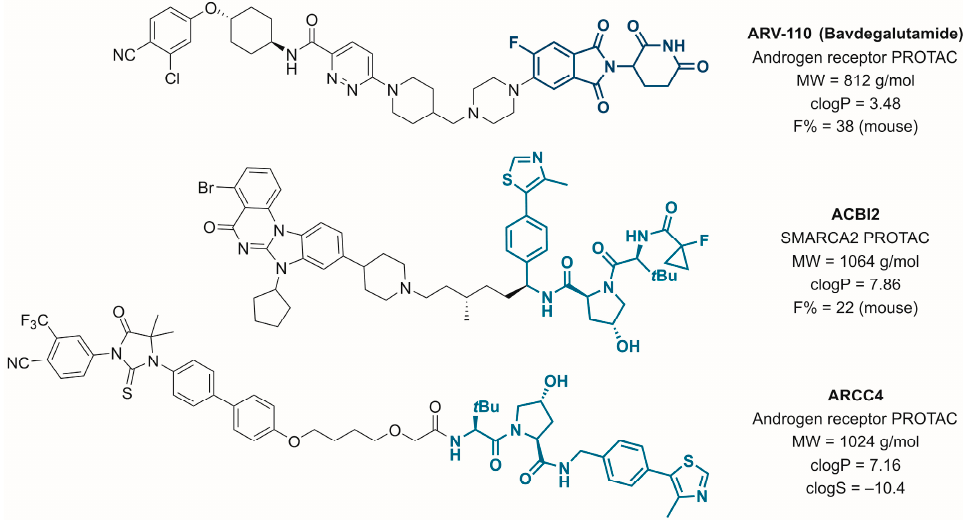
Figure 1. Selected cereblon- and VHL-based PROTACs and key physicochemical properties. As poor aqueous solubility is the main limiting factor contributing to the low bioa- vailability of lipophilic drugs in peroral formulations, developing strategies to overcome the low solubility is necessary [6,7]. In the case of solubility-enhancing peroral applica- tions of PROTACs, recent studies focused on self-emulsifying drug delivery systems [8]. For instance, Rathod et al. developed PROTAC-loaded self-nano emulsifying preconcen- trate using ARV-825 as PROTAC molecule (ARV-SNEP) and significantly enhanced solu- bility in aqueous and biorelevant media [9].